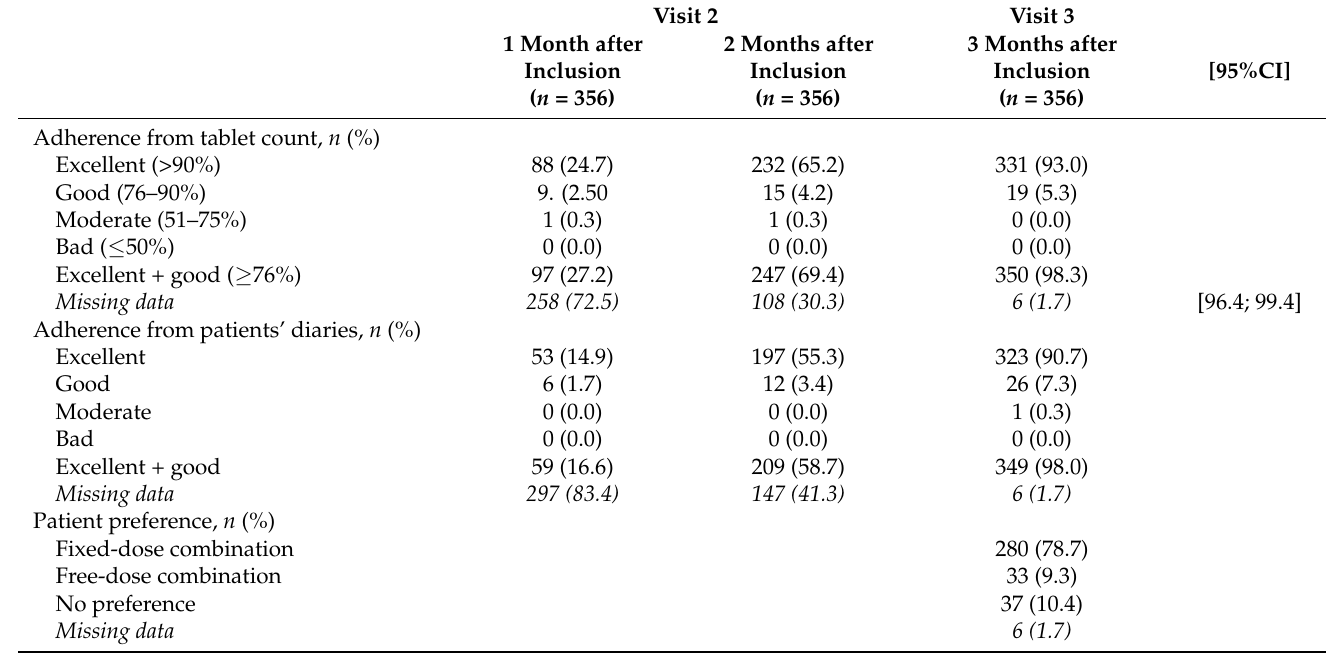
Table 2. Patient adherence and preference (FAS